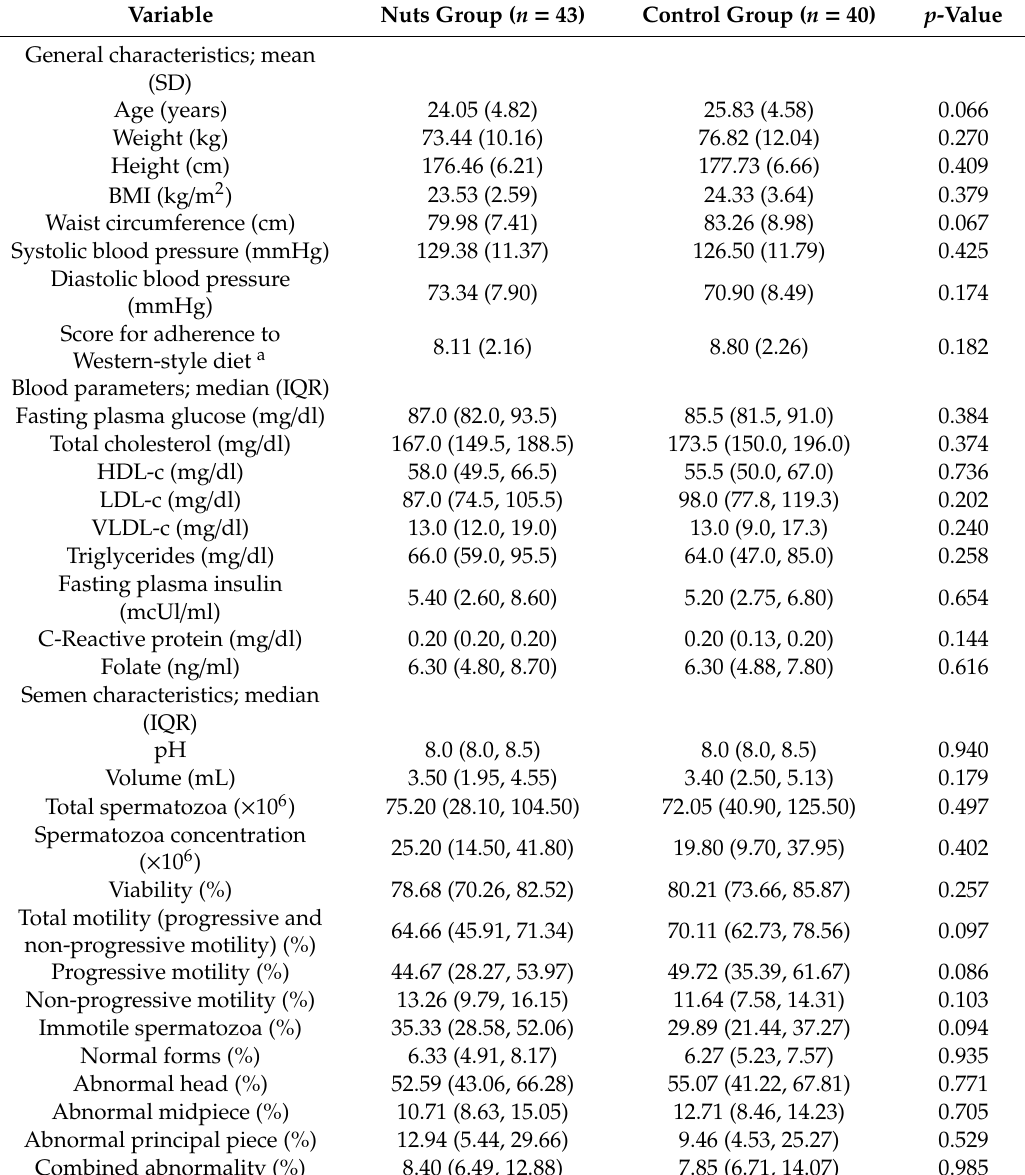
Table 1. Baseline characteristics of the study population (general characteristics, blood, and semen